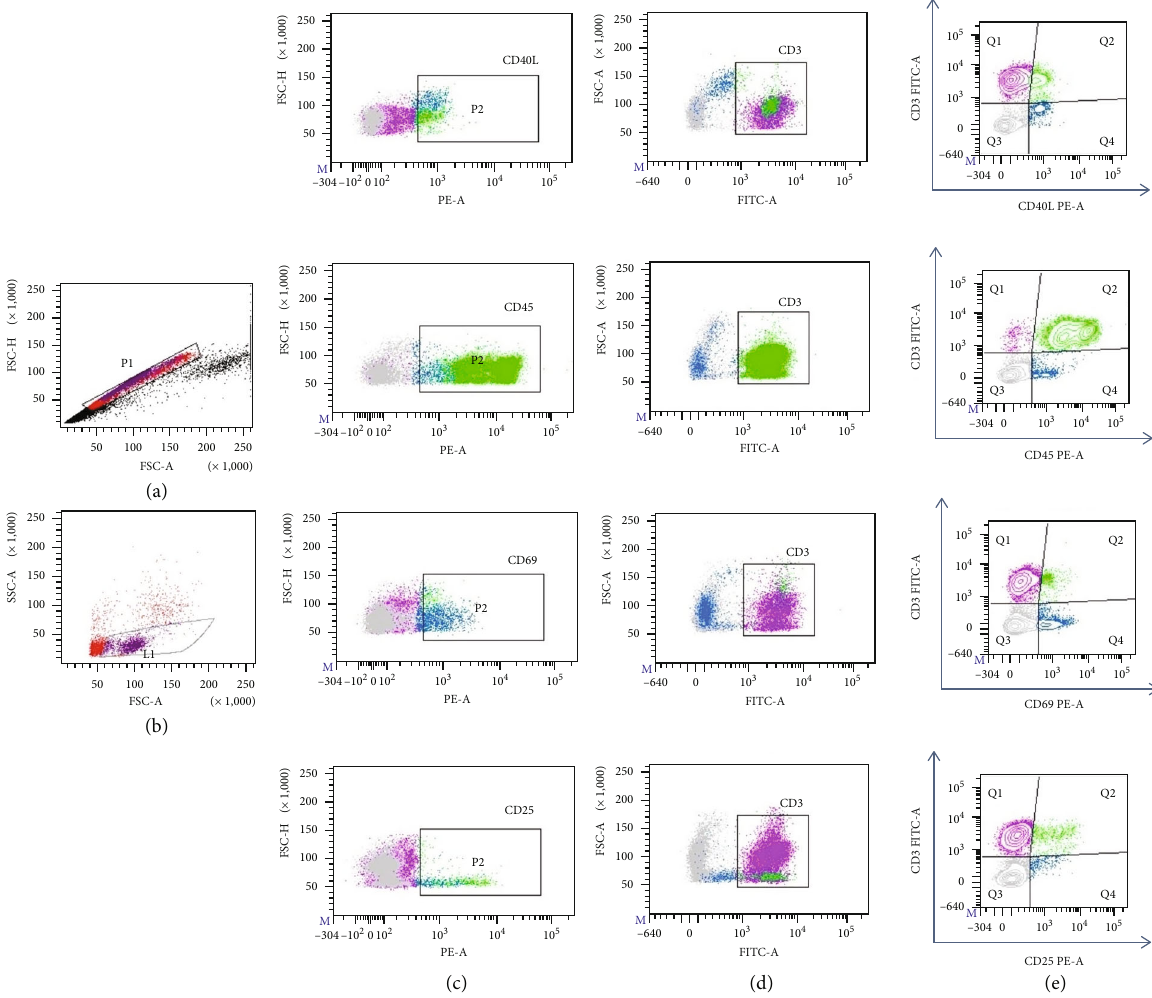
Figure 3: Strategy for the analysis of activation molecules on ex vivo PBMC and CD3 + population in patients with dengue fever (DF) and dengue hemorrhagic fever (DHF). (a, b) First, singlets (P1) and live (L1) cells were selected. (c) Activation molecules were identi fi ed in the PBMC population (P2): CD40L + , CD45 + , CD69 + , and CD25 + subsets are represented from top to bottom. (d) CD3 + cells were gated and used to determine double positive cells. (e) Representative plots of activation molecules (CD40 + , CD45 + , CD69 + , and CD25 + ) expressed in T cells. Q1 represents CD3 + cells; Q2 represents double positive vs. 1 : 03 ± 0 : 7 % ( p = 0 : 28 ), 5 : 7 ± 5 : 2 vs. 1 : 8 ± 1 : 2 % ( p = 0 : 029 Table 3: Analysis of activation molecules on immune cells of ), 3 : 03 ± 2 : 1 vs. 0 : 7 ± 0 : 4 % ( p = 0 : 0034 ), and 1 : 4 ± 1 : 2 vs. dengue patients by fl ow cytometry. 0 : 8 ± 0 : 5 % ( p = 0 : 21 ) either in DF or DHF, respectively. NS3 peptides were more immunogenic than the other pep- tides. Positive control stimulus (PHA) induced proliferation of both CD4 + and CD8 + T cells (around 15%) in both DF and DHF patients. Negative controls increased less than 0.1% for both groups.